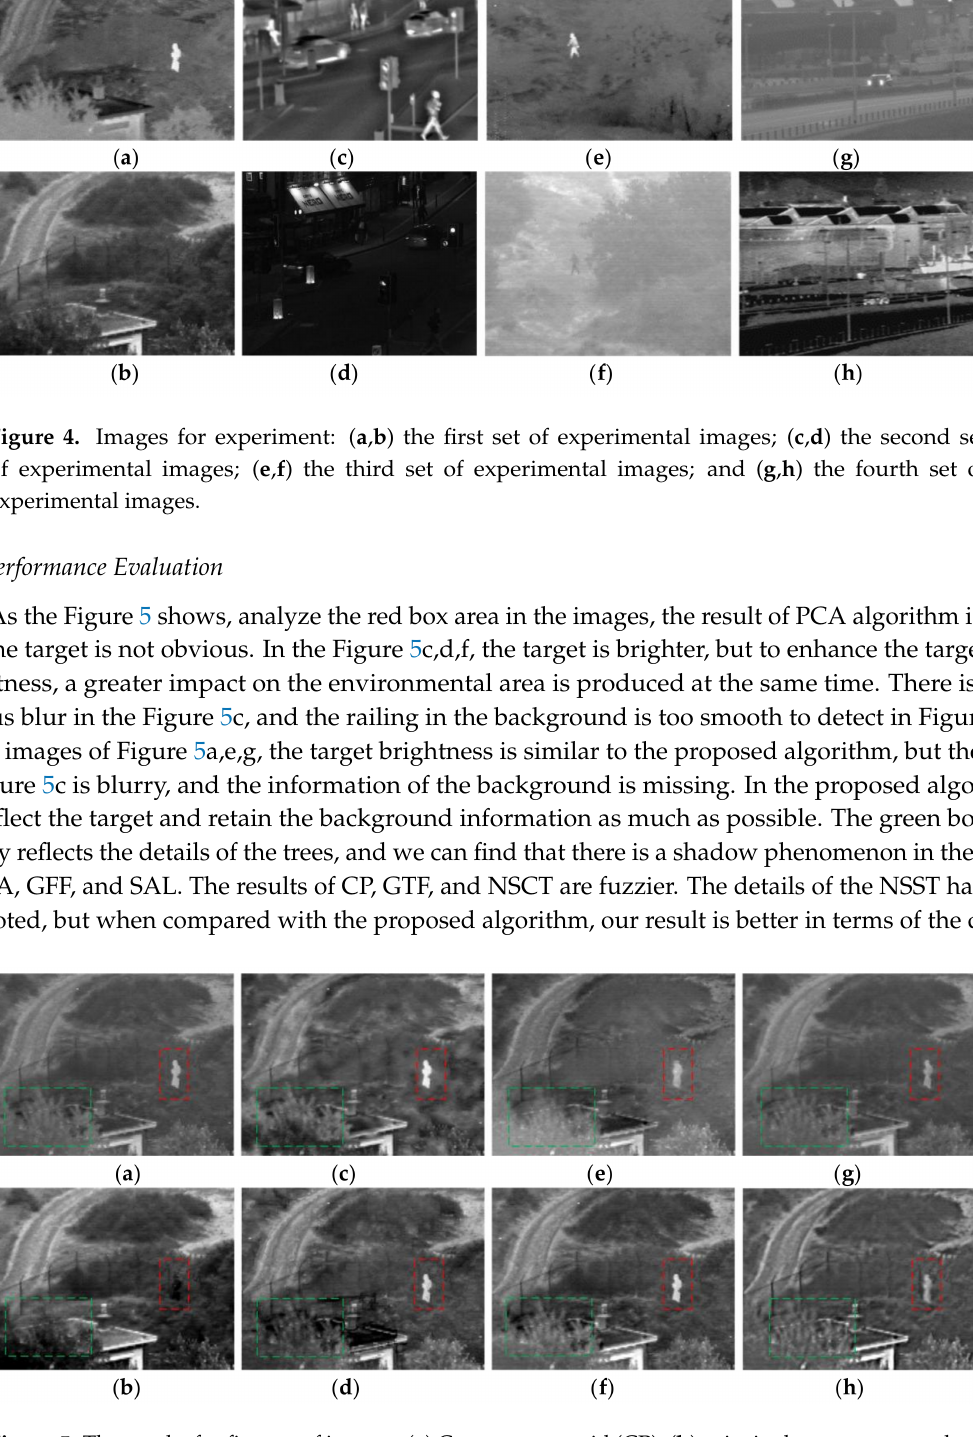
Figure 5. The results for first set of images. ( a ) Contrast pyramid (CP); ( b ) principal component analysis (PCA); ( c ) Guided Filter fusion (GFF); ( d ) saliency fusion (SAL); ( e ) gradient transfer and total variation (GTF); ( f ) non-subsampled Contourlet transform NSCT; ( g ) non-subsampled shearlet transform (NSST); and ( h )